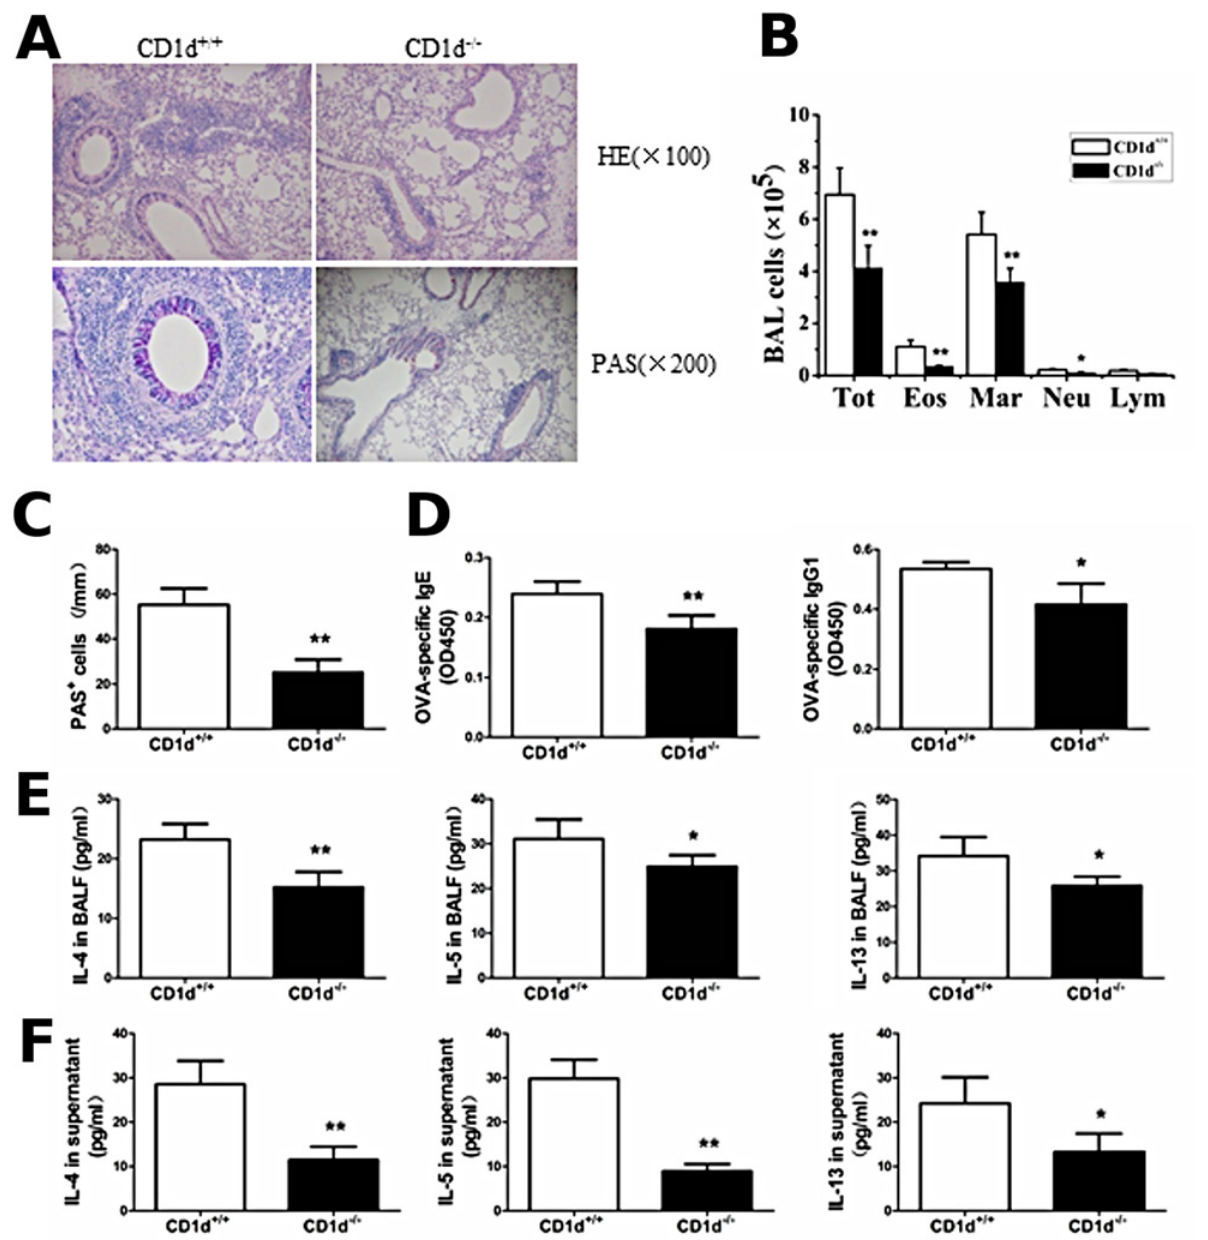
Fig 7. Th2 inflammatory response is reduced, but not completely abrogated in CD1d -/- mice immunized and challenged with OVA, compared with WT (CD1d +/+ ) mice. A . Histopathological analysis using hematoxylin-eosin (H&E) staining and periodic acid-Schiff (PAS) staining of the lung tissue sections from CD1d +/+ and CD1d -/- mice immunized and challenged with OVA. B . Total cell and differential cell counts in the BALF from CD1d +/+ and CD1d -/- mice immunized and challenged with OVA were obtained by a standard hemocytometer. N = 4 per group and * P < 0.05, ** P < 0.01. Tot, total cell counts; Mar, macrophages; Eos, eosinophils; Neu, neutrophils; and Lym, lymphocytes. C . Lung goblet cell hyperplasia is expressed as the number of PAS-positive cells per unit of length (mm) of the basement membrane. N = 4 per group and ** P < 0.01. D . OVA-specific Ig levels from CD1d +/+ and CD1d -/- mice immunized and challenged with OVA were analyzed by ELISA. N = 4 per group and * P < 0.05, ** P < 0.01. E . BALF were collected 24 h after the final challenge and the levels of IL-4, IL-5, and IL-13 from CD1d +/+ and CD1d -/- mice immunized and challenged with OVA were analyzed by ELISA. N = 4 per group and * P < 0.05, ** P < 0.01. F . Splenocytes were obtained from CD1d +/+ and CD1d -/- mice immunized and challenged with OVA and re-stimulated with 500 μ g OVA in vitro . After 72 h, culture supernatants were collected and cytokine production was analyzed by ELISA. N = 4 per group and * P < 0.05, ** P < 0.01.